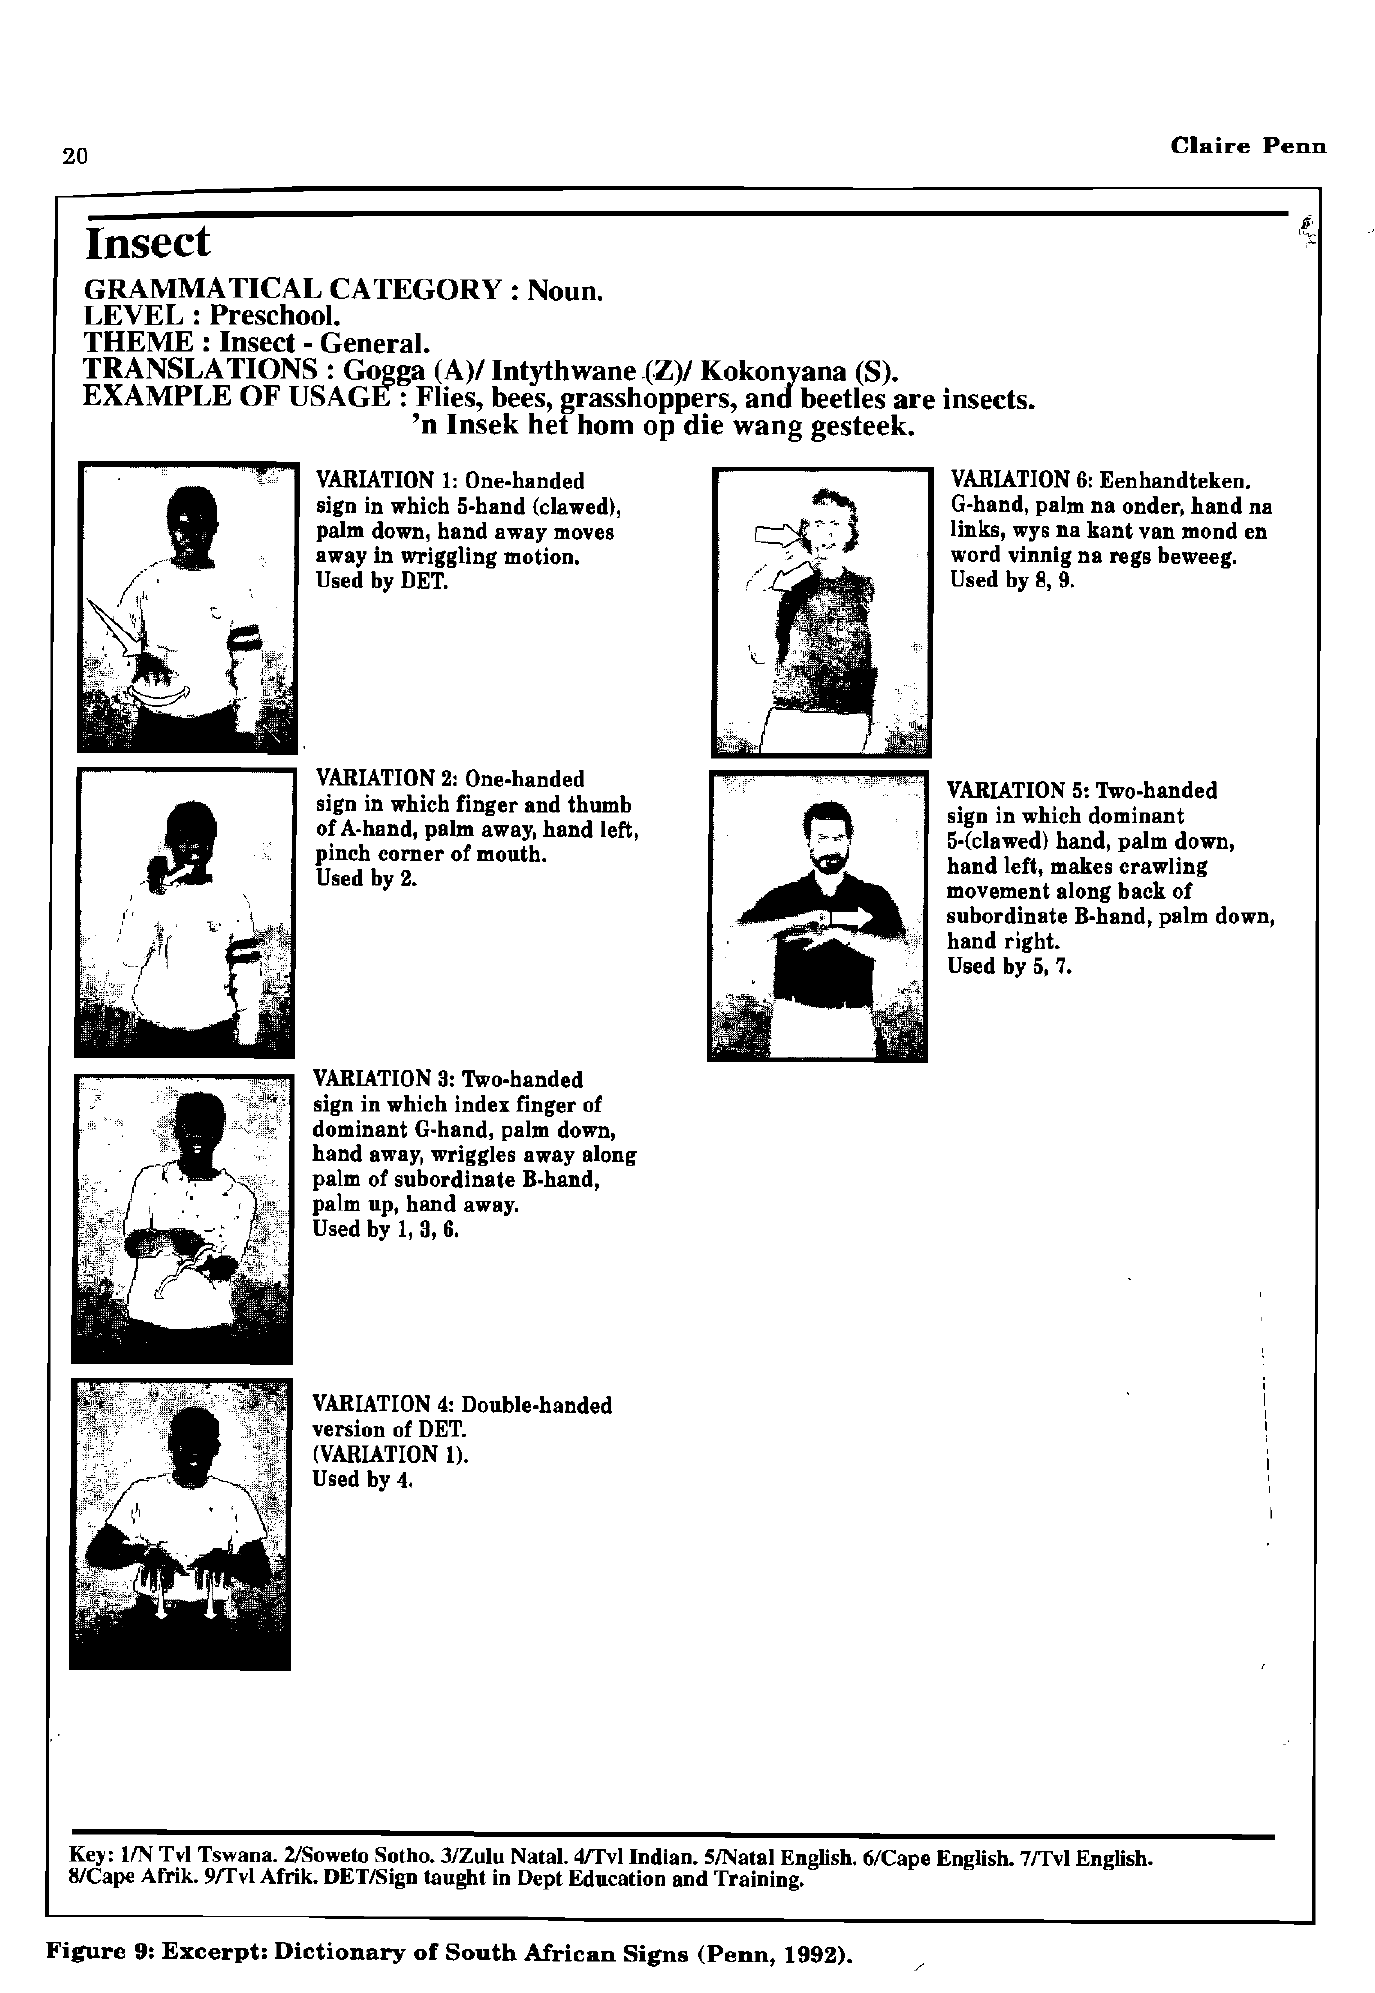
Figure 9: Excerpt: Dictionary of South African Signs (Penn,